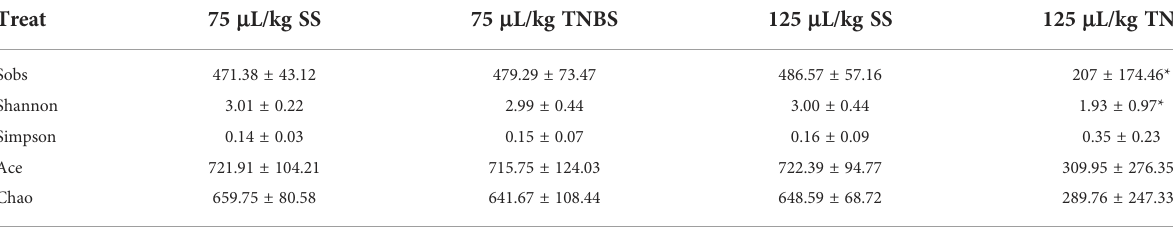
TABLE 2 Alpha diversity of intestinal microbiota after treatment with SS and TNBS.